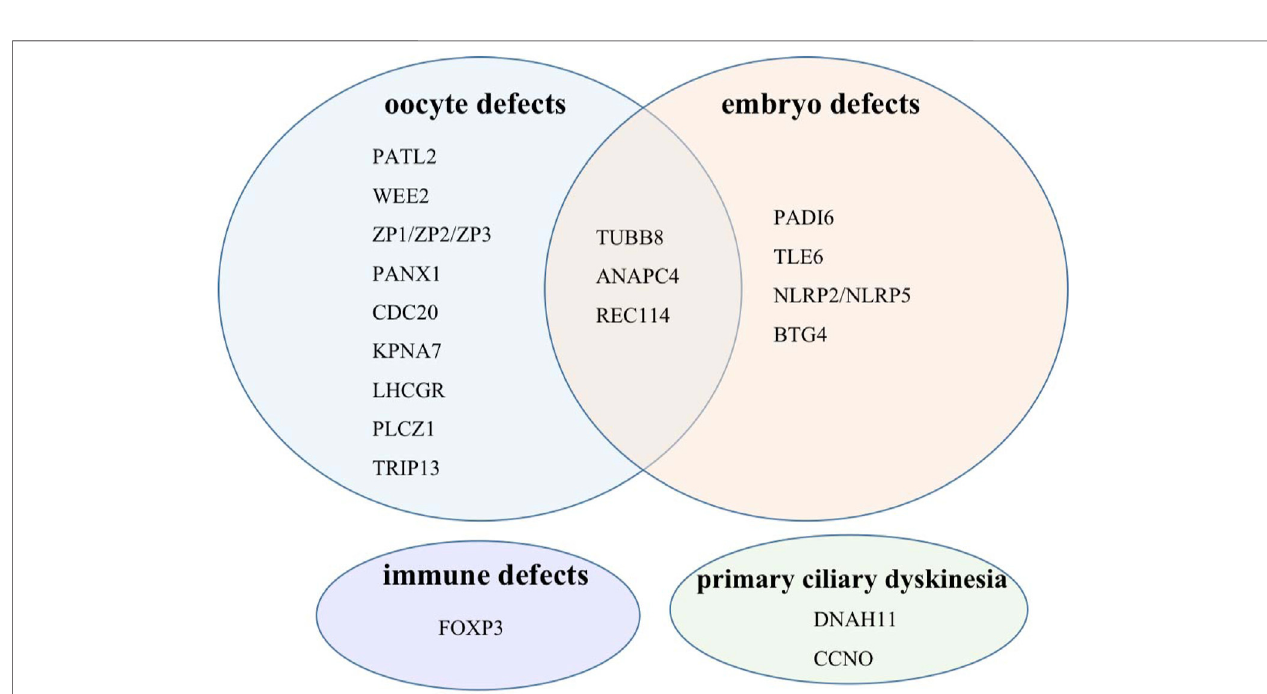
FIGURE 1 | Target genes classi fi ed into four categories according to their